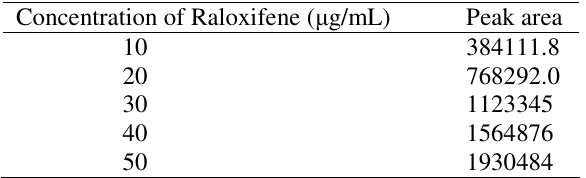
Table 1. Calibration of the Proposed